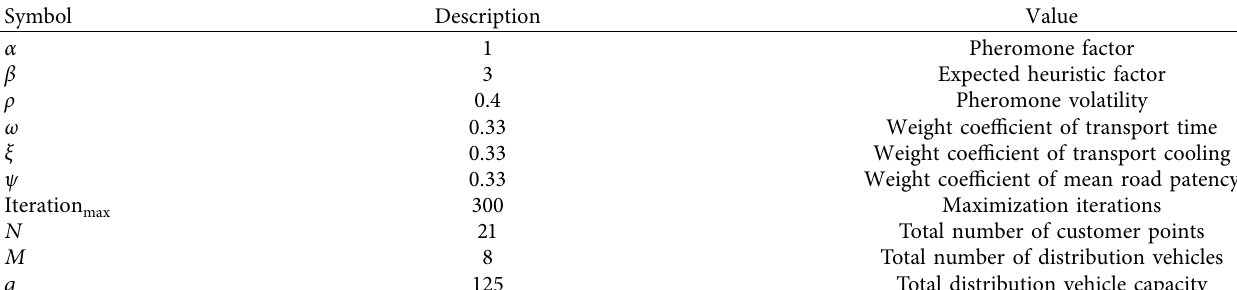
Table 2: Parameters setting of the IACO approach.